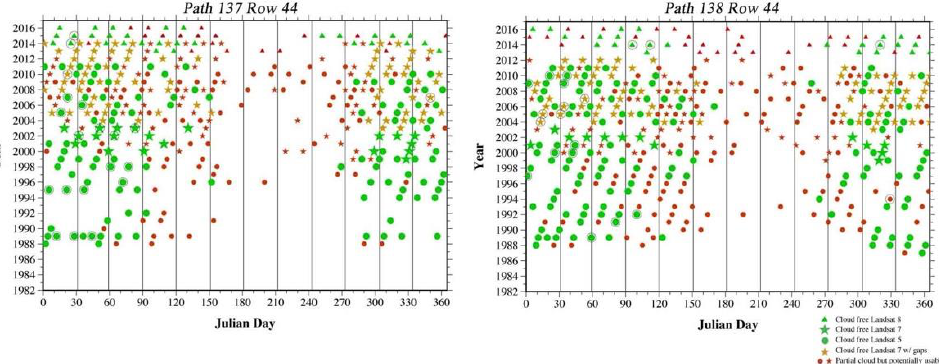
Figure 3. Calendar plots showing temporal distributions of cloud-free (green), partial cloud (yellow), and cloud-contaminated (red) Landsat imagery for the study area over nearly 30 years of Landsat TM, ETM+, and OLI acquisitions. The persistent cloud cover during the monsoon season is evident in the nearly complete absence of cloud-free images in the months of June, July, August, and September.